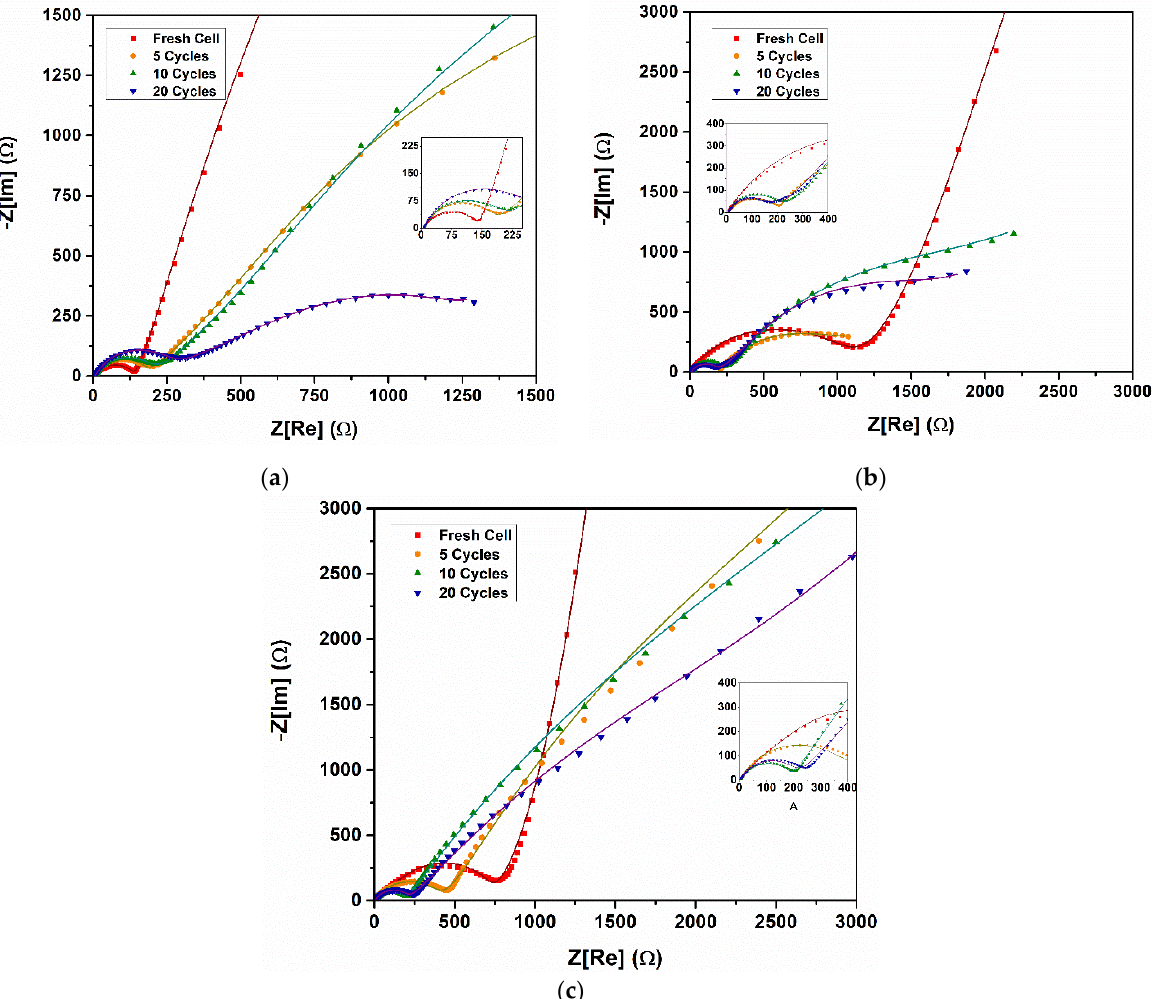
Figure 9. Impedance spectrum of the ( a ) 0.3Li 2 MnO 3 –0.7LiNi 0.5 Mn 0.5 O 2 , ( b ) 0.5Li 2 MnO 3 – 0.5LiNi 0.5 Mn 0.5 O 2 , and ( c ) 0.7Li 2 MnO 3 –0.3LiNi 0.5 Mn 0.5 O 2 cathode materials.